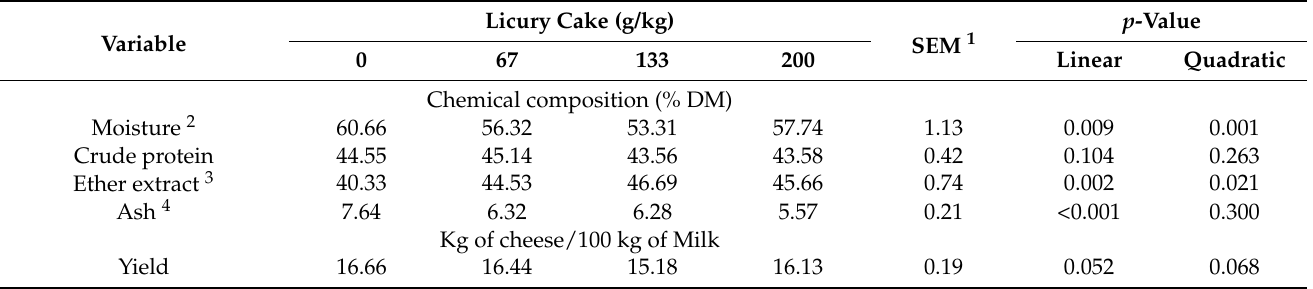
Table 5. Chemical composition and yield of cheese made from the milk of lactating goats fed diets with increasing levels of licury cake.